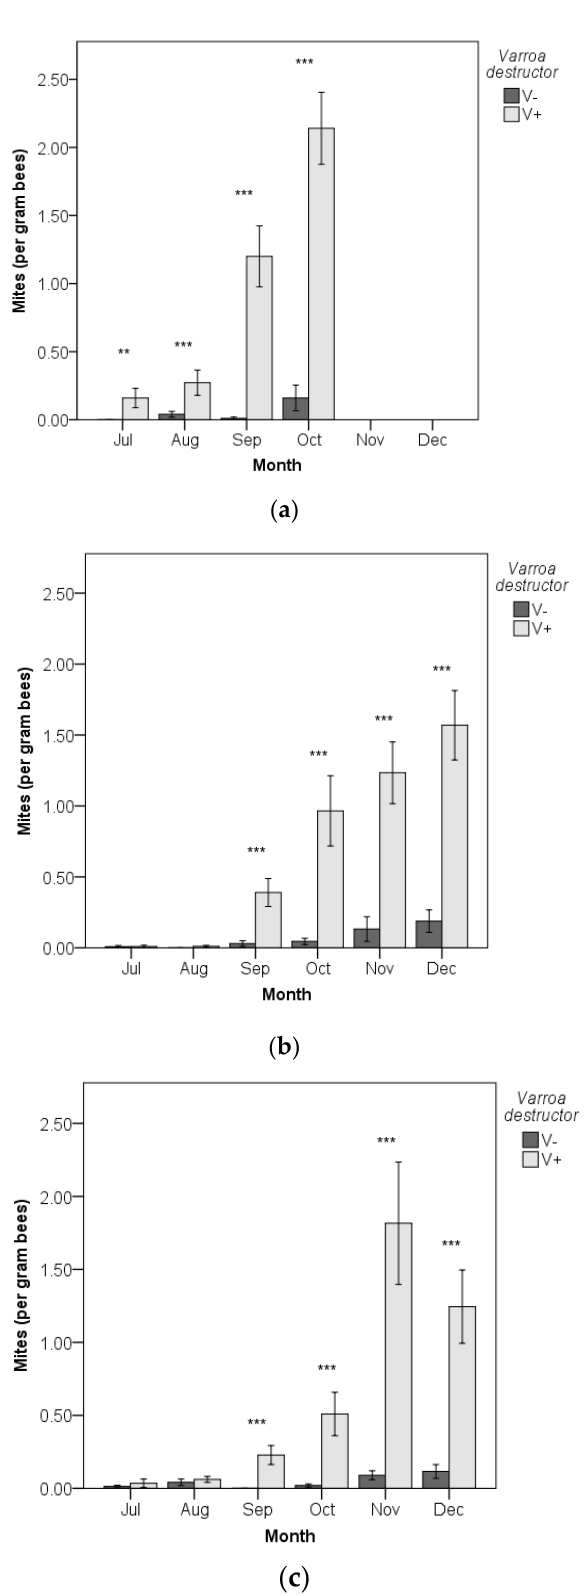
Figure 1. Number of V. destructor mites per gram of bees per month in 2012 ( a ), 2013 ( b ) and 2014 ( c ) for colonies without acaricide treatment (V+, dark grey bars) or with acaricide treatment (V − , light grey bars). Asterisks show differences between V − and V+ (* p < 0.05; ** p < 0.01; *** p < 0.001), where the data for the statistical test were Ln-transformed (+0.0005).